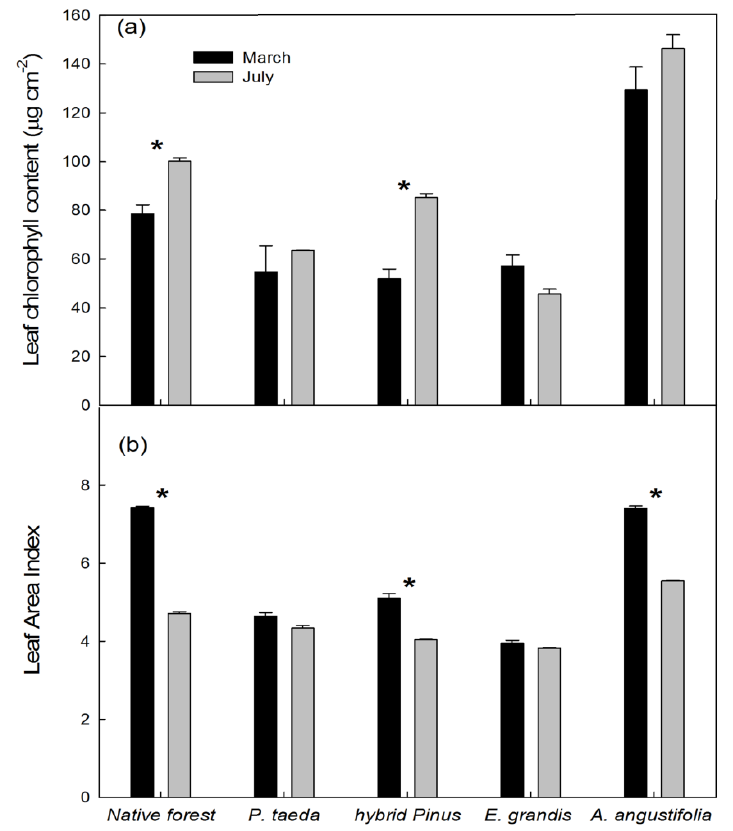
Figure 5. Field measurements of ( a ) chlorophyll content and ( b ) Leaf Area Index for two months: March (black bars) and July (grey bars), corresponding to summer and cold seasons, respectively. Bars are means + SE. In tree plantations n = 3 for chlorophyll content and n = 10 for LAI. In the native forest stands n = 5 for chlorophyll content and n = 30 for LAI. * Indicates significant differences between times (March and July) within each ecosystem type at p <